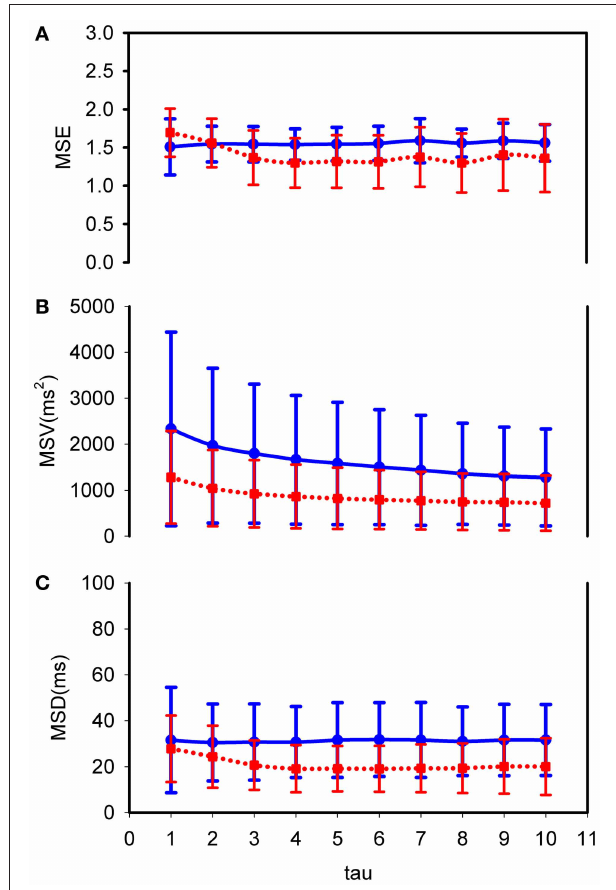
FIGURE 2 | MSE, MSV, and MSD curves: comparison between control subjects and CHF patients in supine posture. (A) MSE; (B) MSV; (C) MSD. Fat (blue) line: control healthy subjects; dotted (red) line: CHF patients. Tau from 1 to 10. The curves represent mean values with ± 1 standard deviation. CHF patients have lower MSE, MSV, and MSD than healthy subjects for tau above